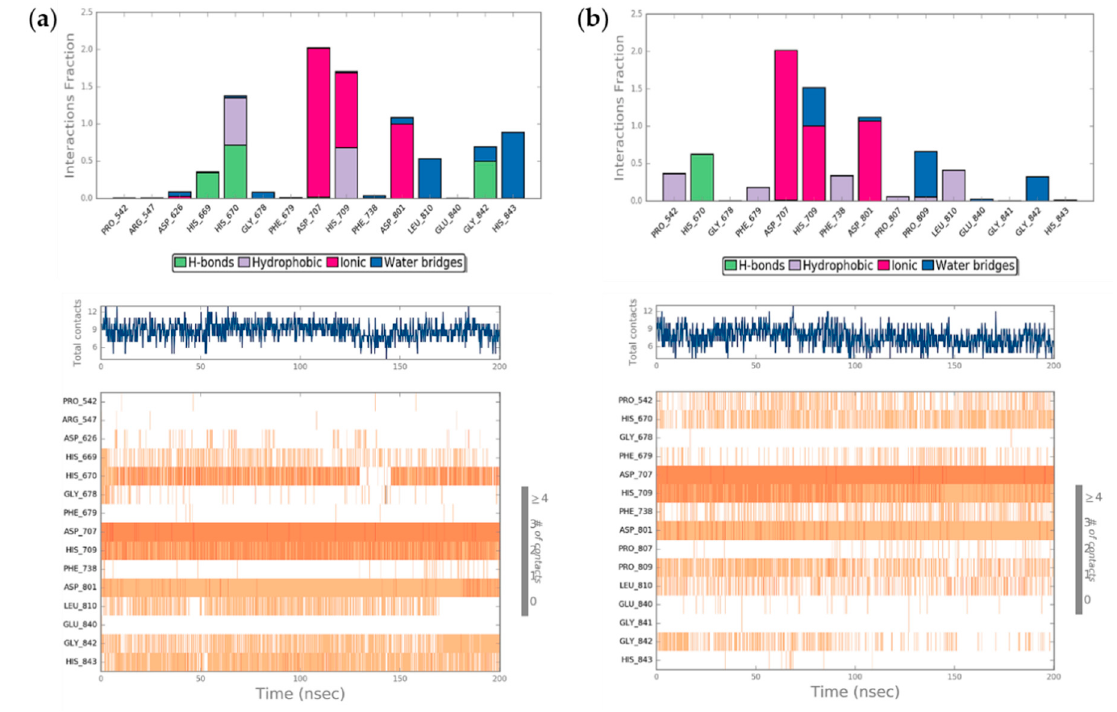
Figure 3. Protein interaction analysis of hit (S)-2 ( a ) and TSA ( b ), monitored throughout the MD simulation. In particular, the fraction of ligand-protein interaction time for protein residues during the simulation is represented in the top panel, while in the bottom the timeline representation of the interactions and contacts throughout the MD simulation is reported.